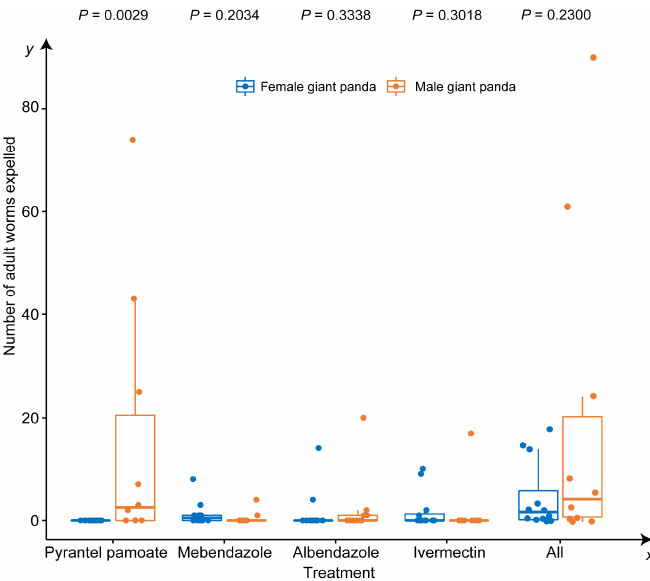
Figure 2. Mean number of worms expelled by different sexes of giant pandas after administration of four anthelmintics.